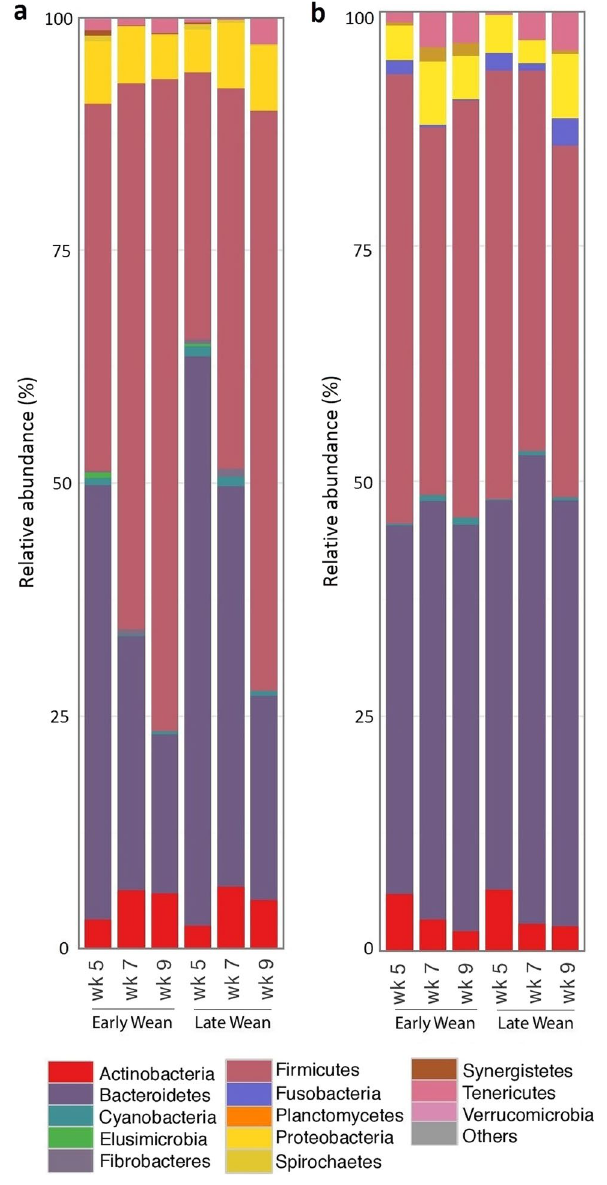
Figure 2. Phylum level composition. Bar plots showing average relative abundance of bacterial phyla (%) in ( a ) rumen and ( b ) faeces of early- (week 6) and late-weaned (week 8) calves for each weaning